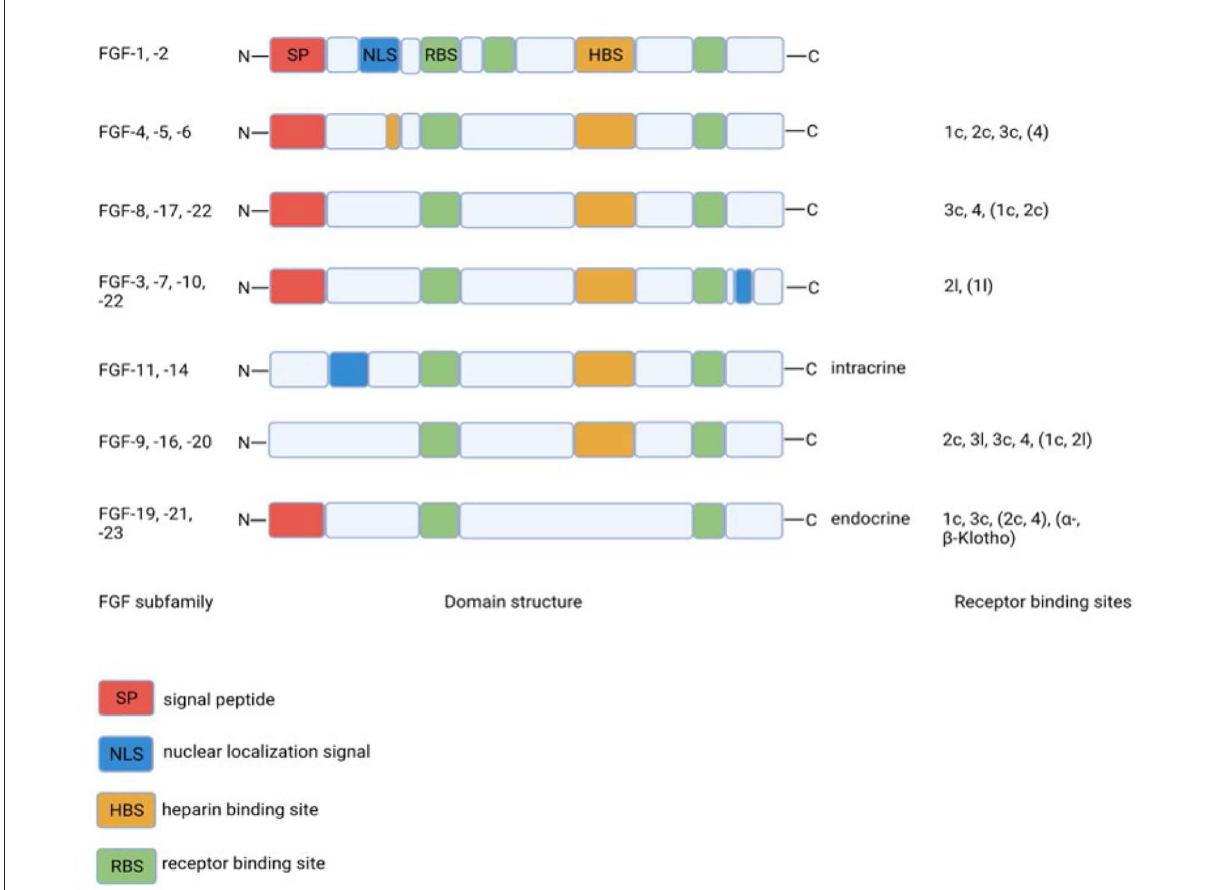
FIGURE1 Structural homology between FGF-family members and binding to specific FGF-receptor subtypes. The lack of the heparin binding site in the endocrine FGF19 subfamily clearly discriminates this subfamily from the other FGF-family members. Created with BioRender.com.